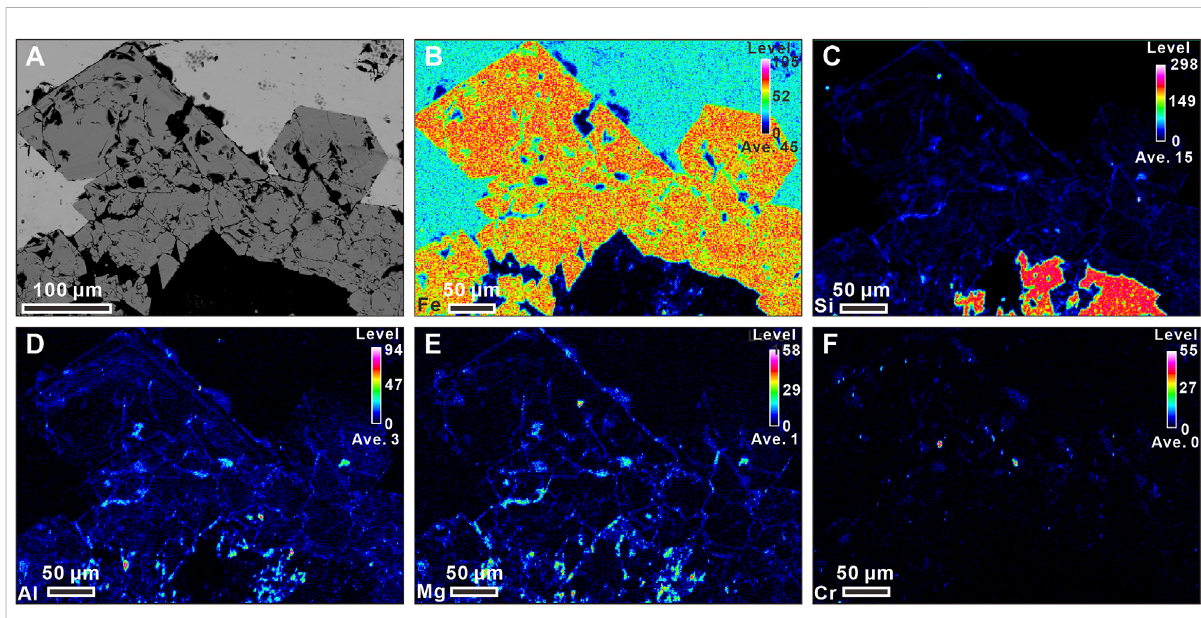
FIGURE 8 BSE image (A) and maps of Fe (B) , Si (C) , Al (D) , Mg (E) and Cr (F) in zoned magnetite from Tongjing Au-Cu